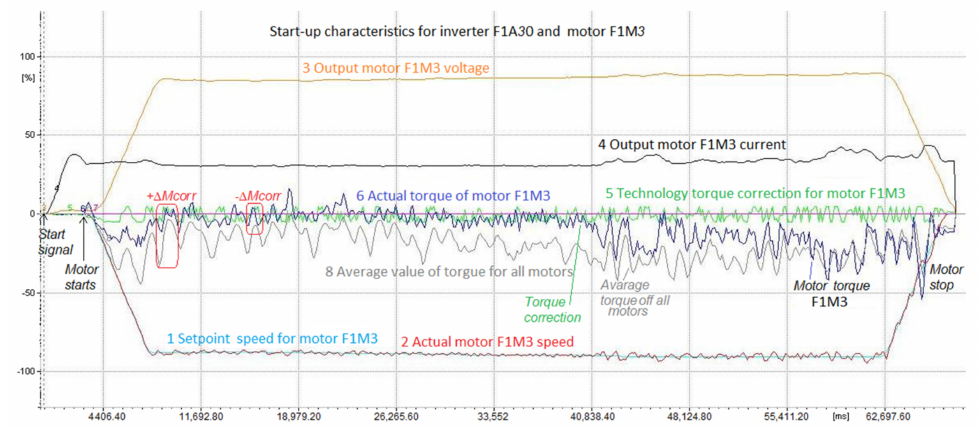
Figure 10. Starting curves of the F1M3 stacker motor with torque